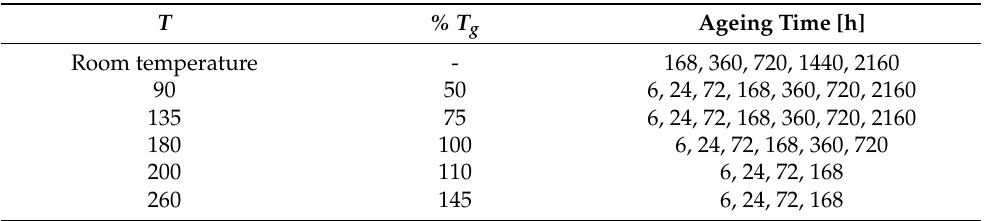
Table 2. Ageing conditions of the CFRP samples. The ageing temperature T , its value expressed as a percentage of the glass transition temperature, and the ageing time in hours are